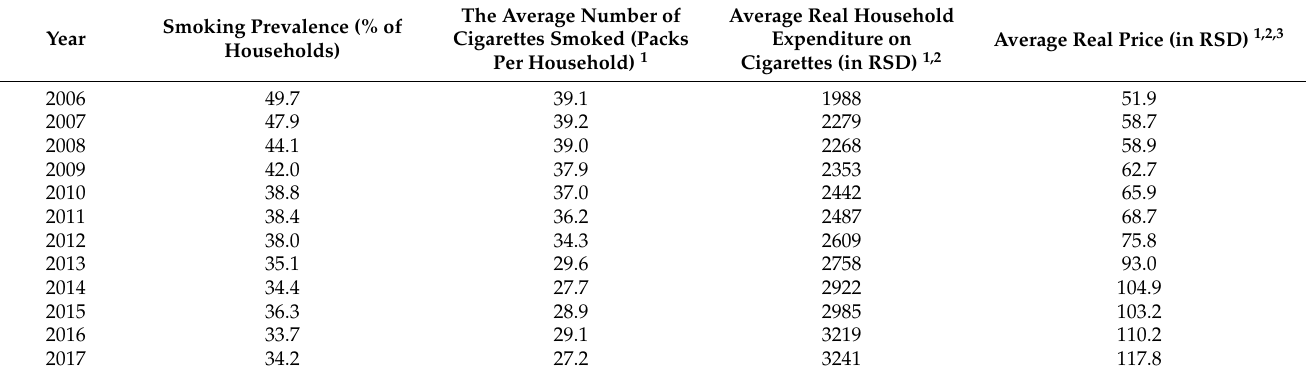
Table 1. Cigarette use in Serbia: prevalence, expenditures, number of consumed cigarettes. The Average Number of Smoking Prevalence (% of Cigarettes Smoked Year Households)